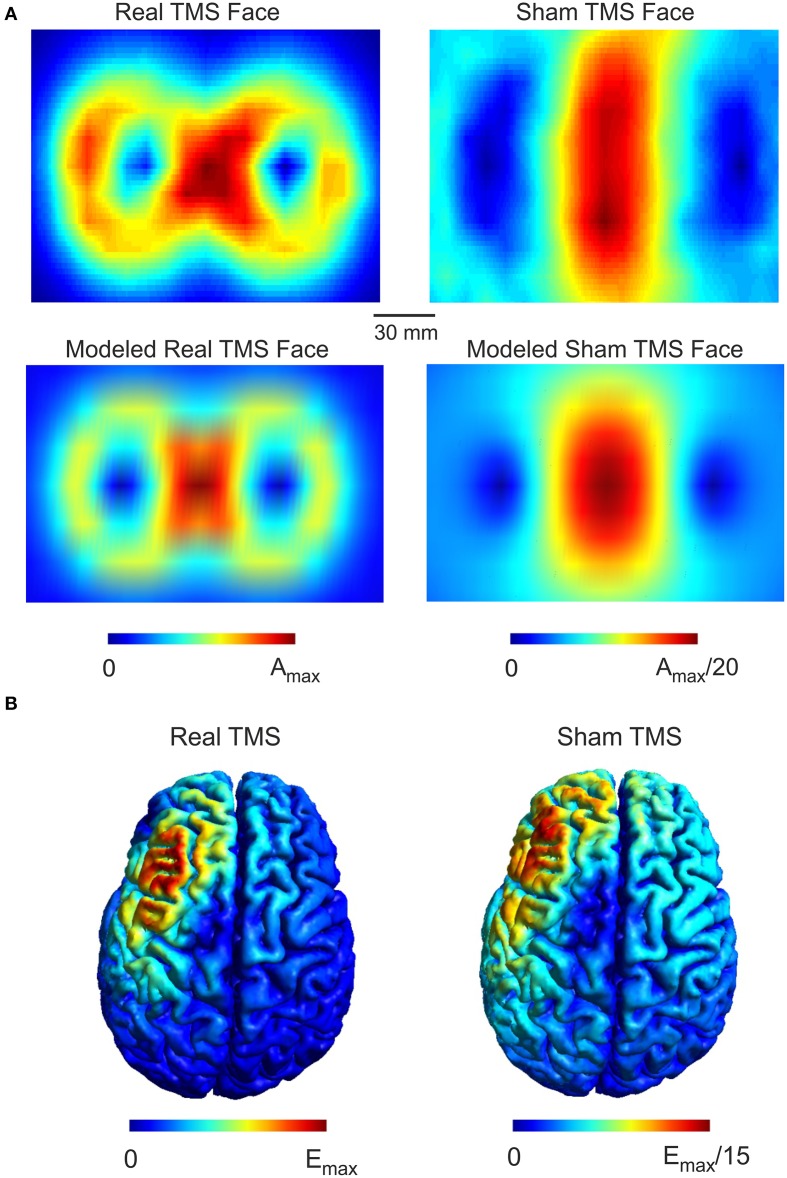
Real and Sham TMS fields. (A) Distributions of the magnetic vector potential for the real and sham side of the TMS coil. The upper panels illustrate measured values for both real and sham faces of the coil while the lower panels illustrate the modeled field distribution. The magnetic vector potential for the real side is about 20 times stronger than for the sham side. The coil models faithfully capture the measured field distribution as illustrated. (B) The simulated electric field distributions generated by real and sham cTBS of the left DLPFC. The electric field strength generated by real TMS is about 15 times stronger than the electric field strength produced by sham TMS. The spatial distributions of the electric field generated by real and sham TMS were strikingly similar to one another.